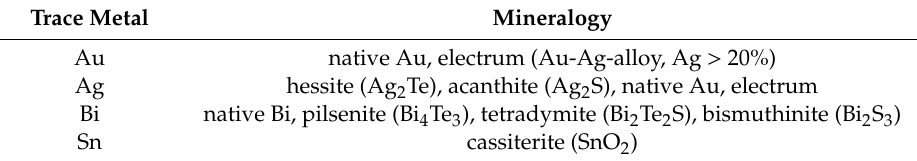
Table 1. Trace metal mineralogy of the Liikavaara Cu-(W-Au)